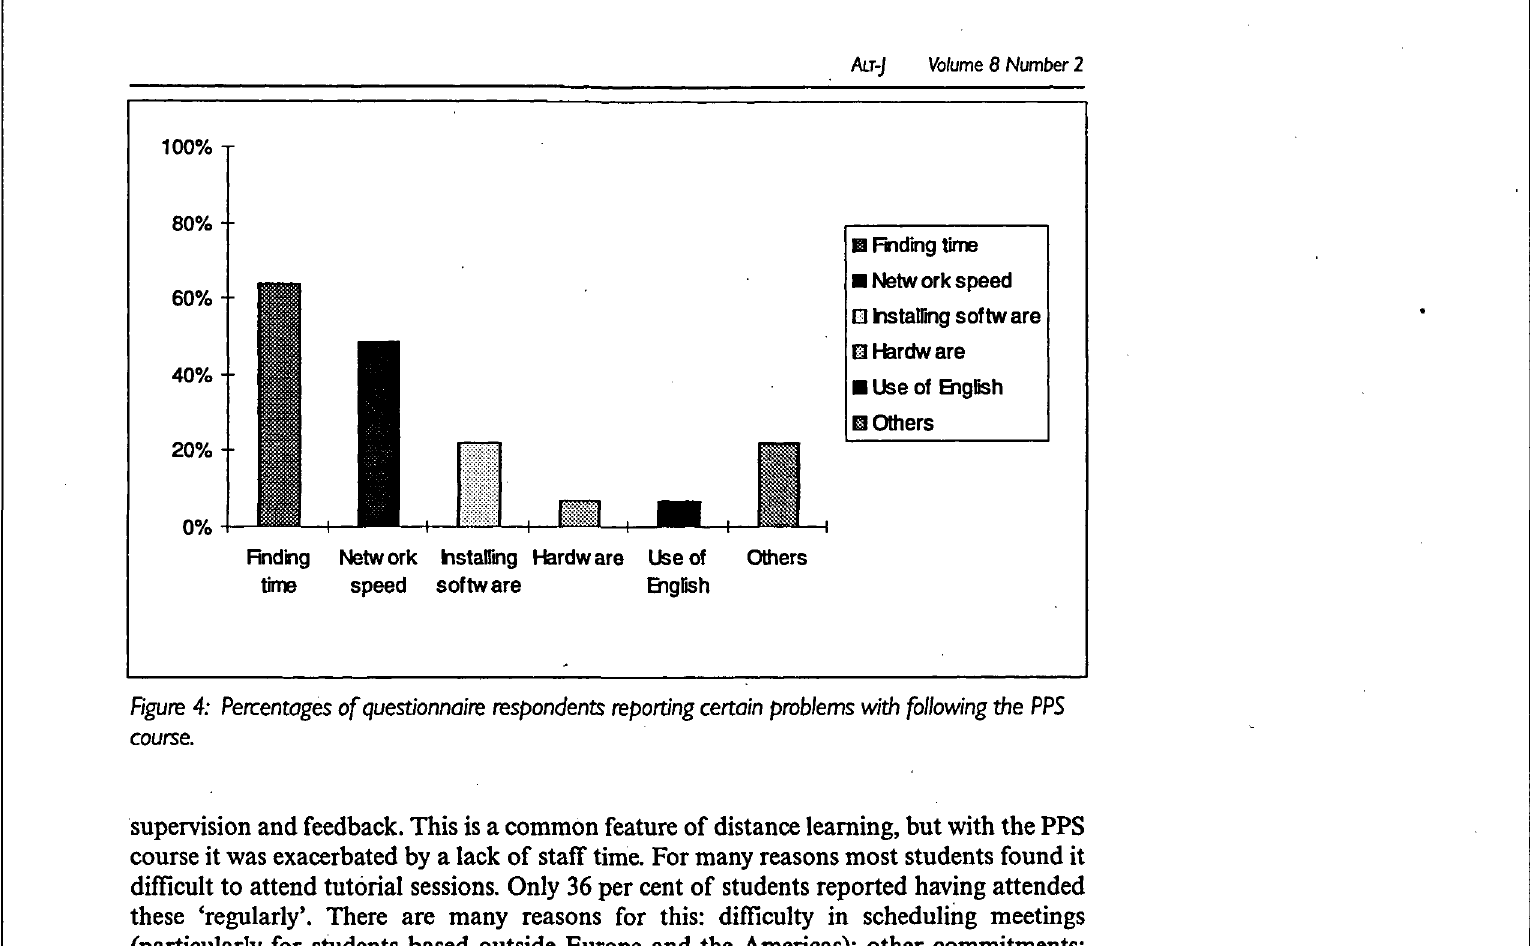
figure 4: Percentages of questionnaire respondents reporting certain problems with following the PPS